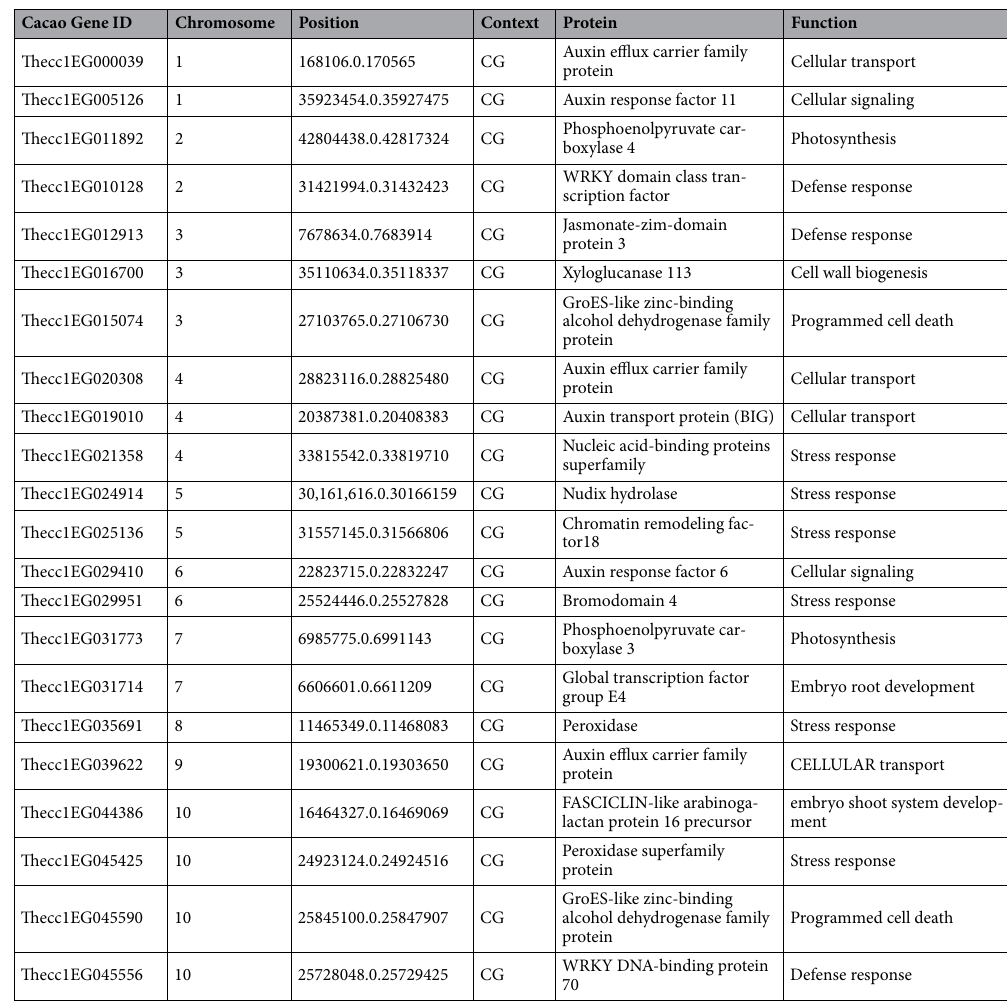
Table 2. Differentially methylated genes in ZE, normal and abnormal SE with important functions in cellular process implicated in embryos development, stress response, defense response and